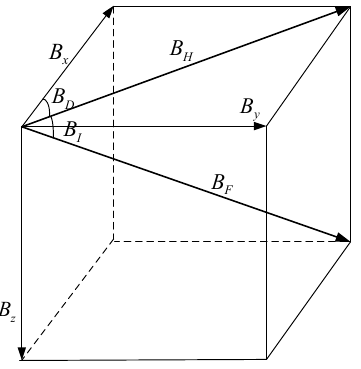
Figure 3. Geomagnetic seven components.